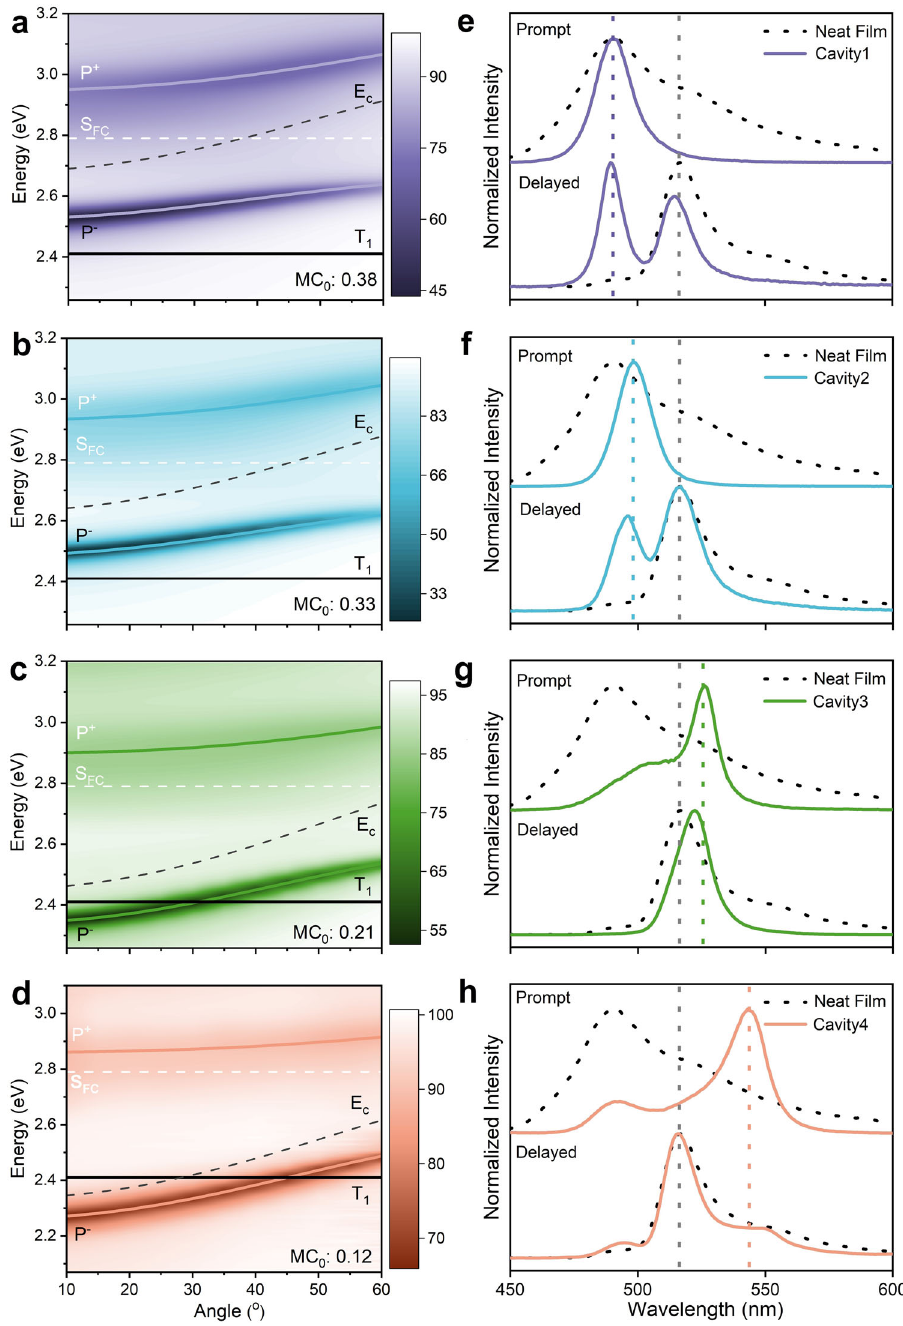
Fig. 2 Characterization of strong light-matter coupling. a – d Angle dependent re fl ectance of Cavity1 ( a ), 2 ( b ), 3 ( c ), and 4 ( d ) with molecular energy levels (S FC = Frank-Condon state, T 1 = Triplet state, and E c = Cavity energy) and fi tted polariton dispersions (P + and P – ), MC 0 indicate the molecular contribution to P – at 0°. e – h Prompt (recorded at room temperature) and delayed (recorded at 77 K) emission spectra of a neat fi lm (dashed black line), Cavity1 ( e ), 2 ( f ), 3 ( g ), and 4 ( h ). For Cavities 1 – 3 the polariton emission maxima moves to higher energies upon cooling. The blue shift is of the same magnitude (approximately 2 nm) and therefore attributed to a small contraction of the fi lm when cooling. The emission maximum of phosphorescence from a neat fi lm is indicated with a vertical gray dashed line in all graphs, and the energy of the lower polariton, as deduced from re fl ectivity measurements, is indicated with a vertical dashed line of corresponding